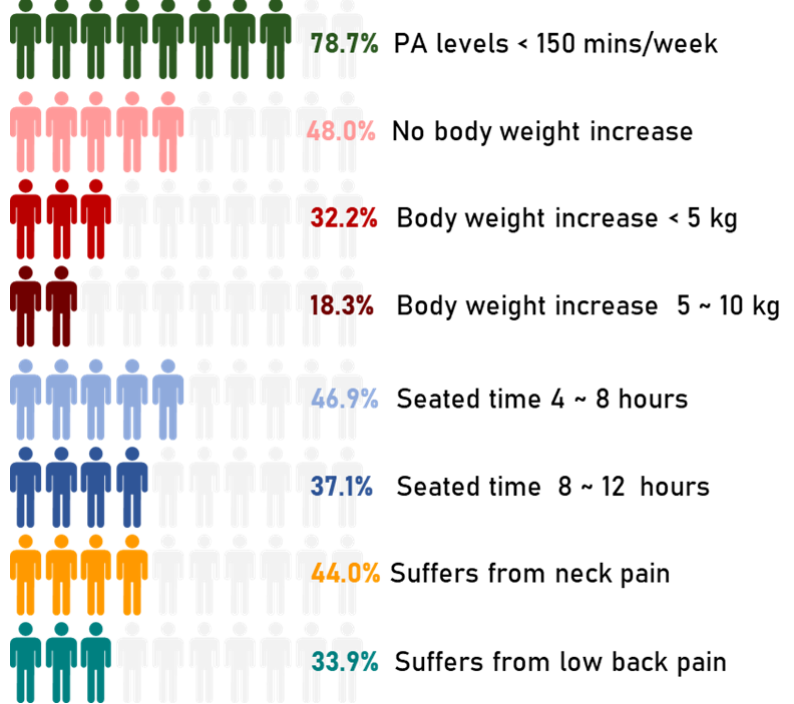
Figure 5. Primary outcomes of the present study. The representation is counted as n /10 based on the respective data.